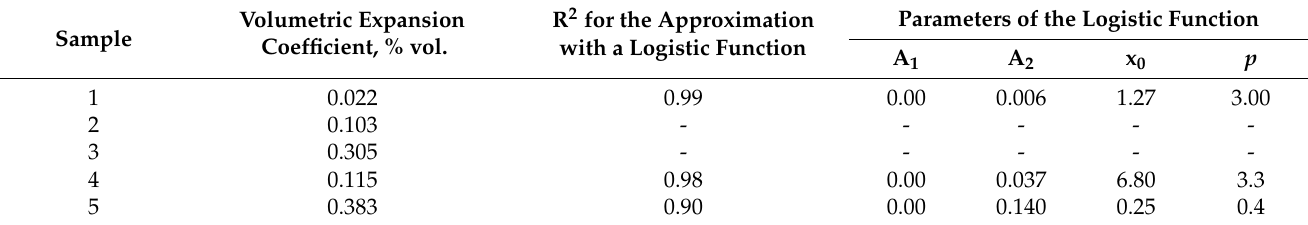
Table 5. Results of the crushed rock swelling experiments in the presence of supercritical CO 2 . Sample